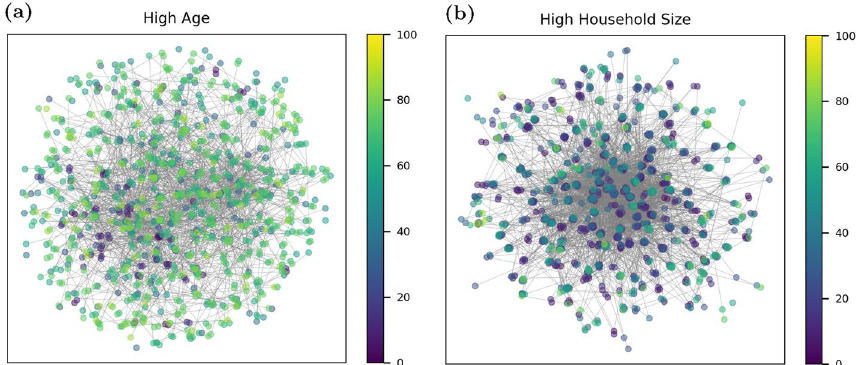
Fig. 4 Example community network realization colored by node age for a High Age community, and b High Household Size community